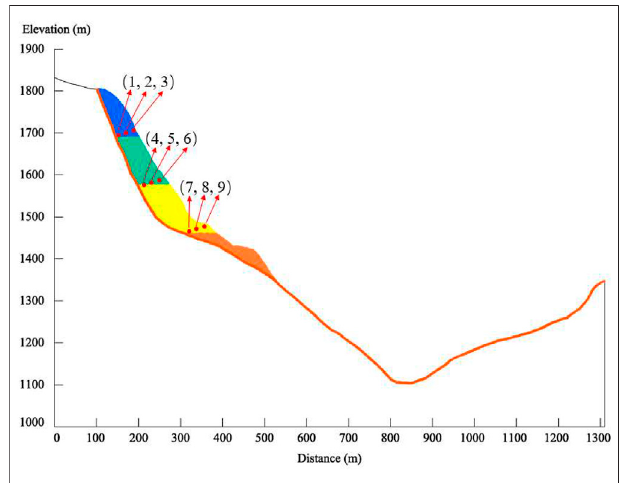
FIGURE 7 | Monitoring point distribution in the MPM model of the Hongshiyan